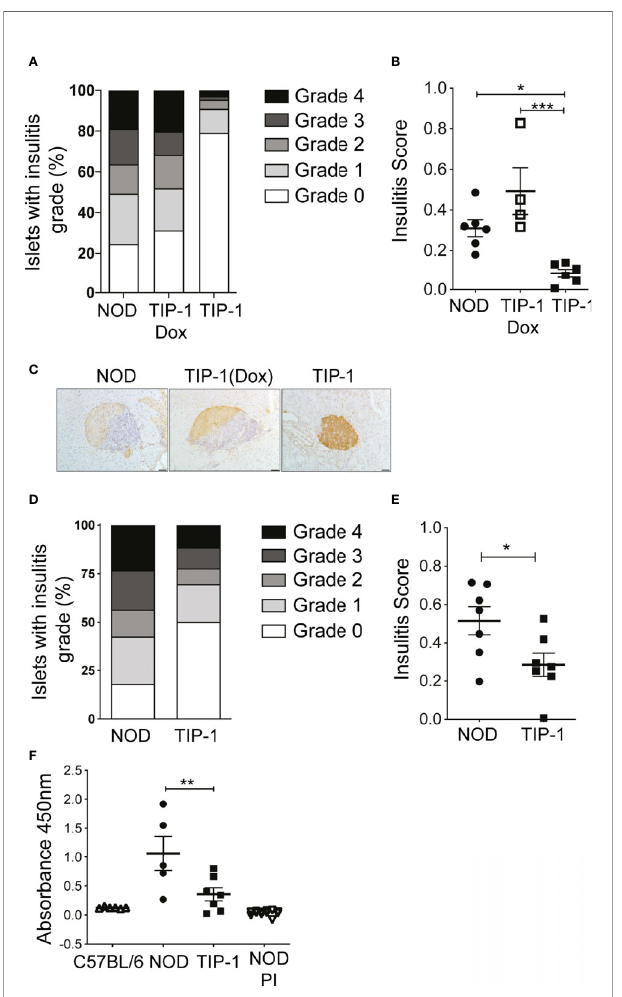
FIGURE 2 | Insulitis and insulin autoantibodies (IAA) in TIP-1 mice (A, B) Histological grading and individual insulitis scores in NOD mice, Doxycycline treated and untreated TIP-1 mice at 12-14 weeks of age. (C) Representative images of islet histology from 12-14 week old NOD, TIP-1 and Dox treated TIP-1 mice, 200x magni fi cation, scale bar 50 m m. (D, E) Histological grading and individual insulitis scores at 20-25 weeks of age in NOD mice and TIP-1 mice (n=4-7, > 60 islets scored per mouse). (F) Sera from 12-16 weeks old C57BL/6 mice, NOD mice, TIP-1 and NOD-PI mice were tested for the presence of insulin autoantibodies (IAA) by ELISA assay. Absorbance values at 450nm are plotted. Each symbol in the scatter plot represents data from individual animals. Data plotted as Mean ± SEM, ***P < 0.001,**P < 0.01, *P < 0.05. Data compared using One-way ANOVA with Sidak ’ s multiple comparisons test (B, F) and 2-tailed unpaired t-test (E) .